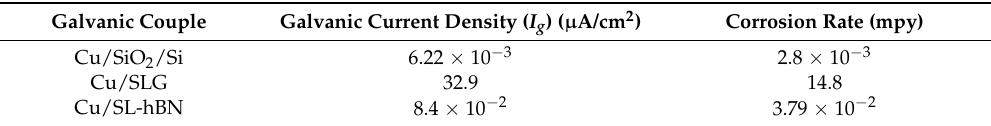
Figure 10. ( a ) and ( b ) Evolution of galvanic corrosion current density ( I g ) and galvanic potential with increasing time, respectively, for different galvanic systems: Cu/SLG, Cu/SiO 2 /Si and Cu/SL-hBN in Desulfovibrio alaskensis G20 lactate C medium. With an anode to cathode area ratio of 1.7, Cu acts as anode and corrosion occurs. Reprinted with permission from ref. [49]. Copyright 2018 American Chemical Society. Table 2. Galvanic corrosion current density and corrosion rate. Reprinted with permission from ref. [49]. Copyright 2018 American Chemical Society.